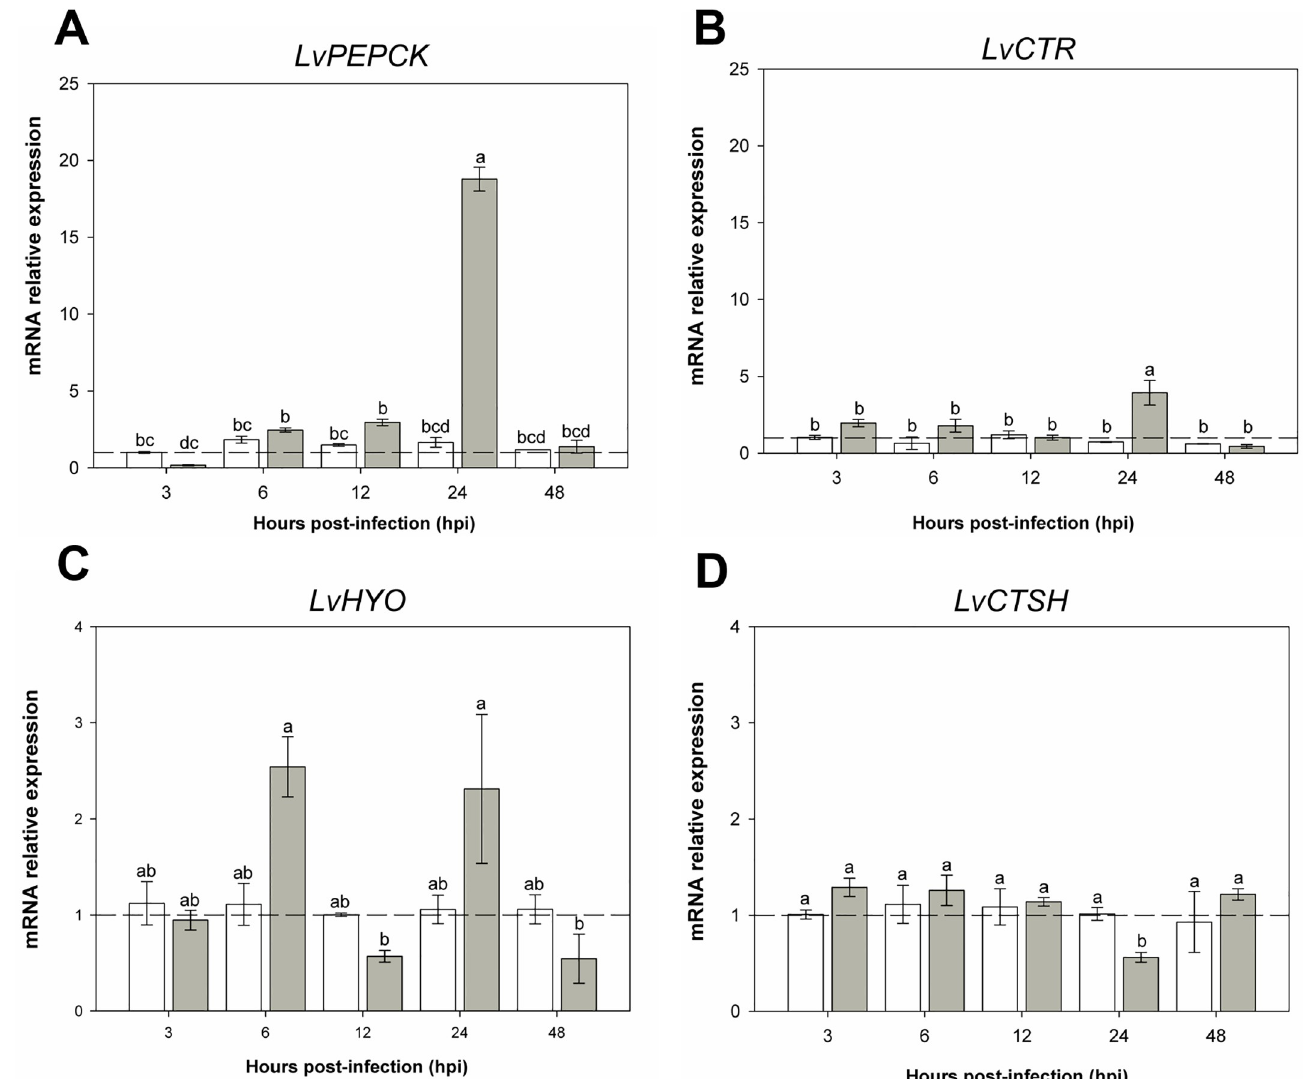
Fig 9. mRNA expression of metabolic process- related genes. RT-qPCR results showing the relative mRNA expression of DETs. For all the charts, the X-axis shows different time point post-infection (shown as hpi), the Y-axis shows relative mRNA expression (target gene/ LvRPL7 ); bars show the mean and error lines the standard error (n = 9). Dash line represents the normalized value and lower case letter(s) show statistically significant differences (p < 0.05). A) Phosphoenolpyruvate carboxykinase. B) Chymotrypsin. C) Hypoxia up-regulated protein. D) Cathepsin L